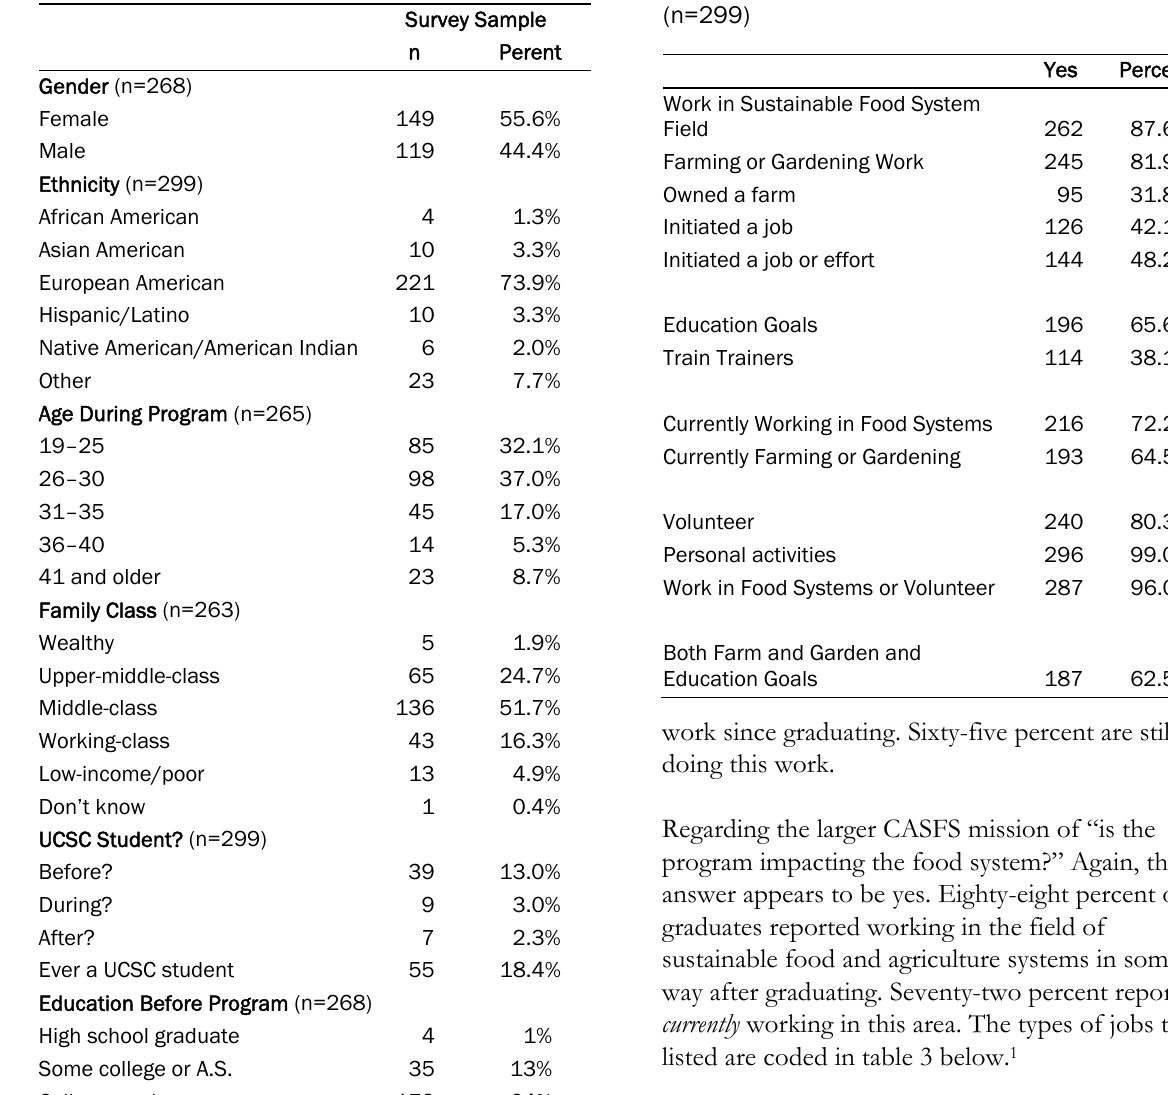
Table 1. Characteristics of Survey Respondents Table 2: Activities respondents have done